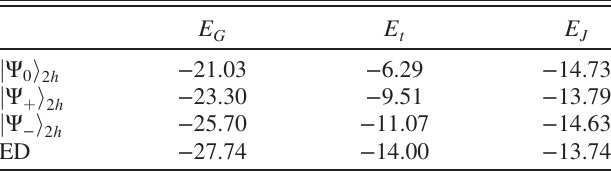
TABLE III. Ground state energies of two-hole-doped 10 × 2 ladder under the OBC obtained by VMC and ED. E energy, E and E are the kinetic and the superexchange energies, t J respectively.